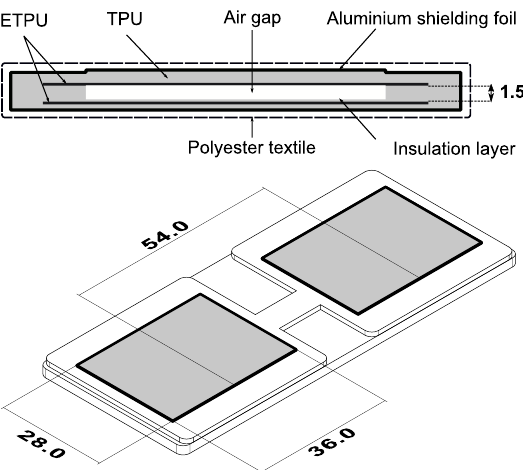
Figure 2. The flexible pressure sensors described in this work measure the change of capacitance in between two flexible conductors (ETPU). The change in capacitance arises due to the fact that the material is flexible and, therefore, will be easily deformed when a force is applied.